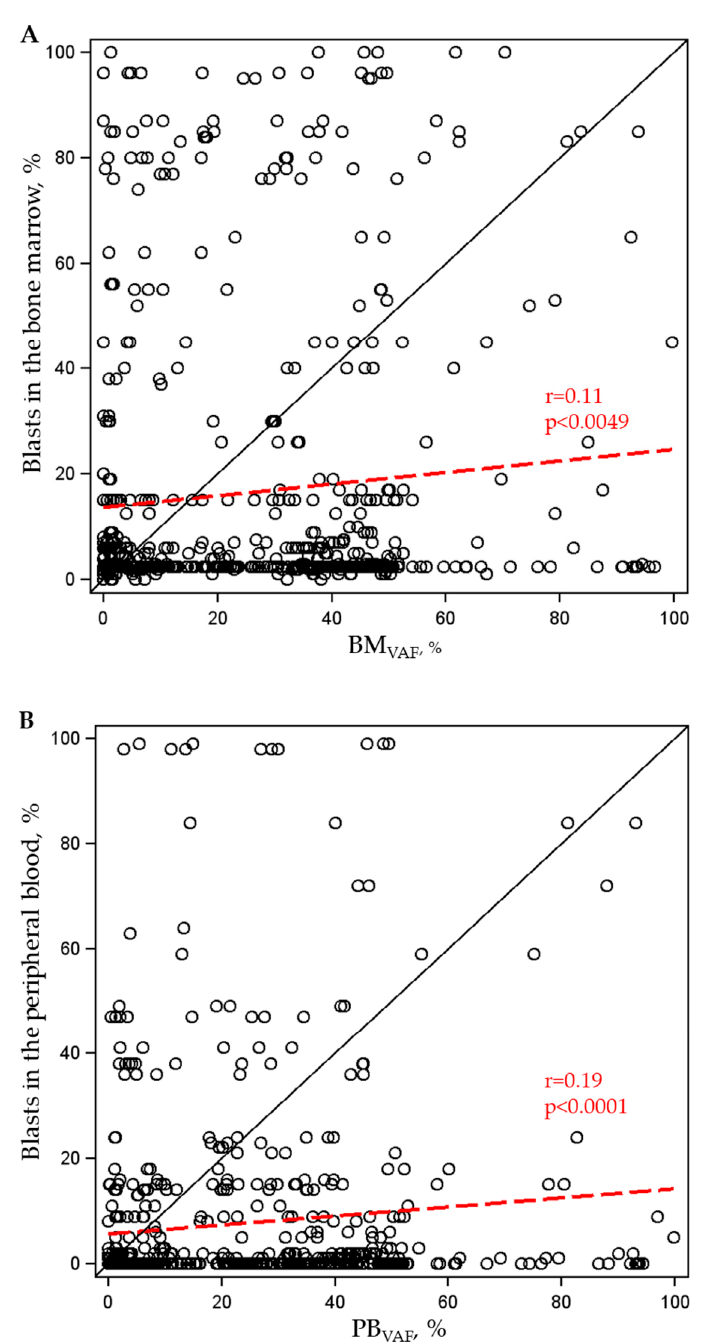
Figure 5. Scatterplots of the “variant allele frequency (VAF) of a mutation” vs. “blast percentage”. ( A ) “BM VAF ” vs. “percentage of bone marrow blasts”. ( B ) “PB VAF ” vs. “percentage of peripheral blood blasts”. The black line is the bisecting line showing a perfect linear regression with slope = 1 and intercept = 0. The red dashed line is the regression line, indicating the correlation between BM VAF and PB VAF of each paired sample.